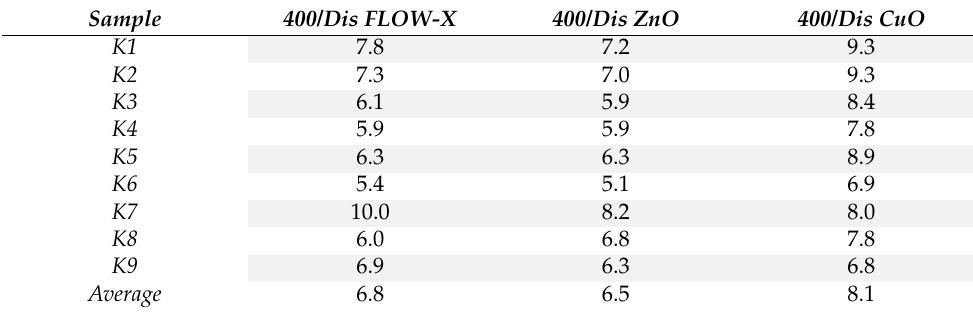
Table 6. Efficiency 1 ppm of inhibitor to 1% percent of asphaltene dispersion.